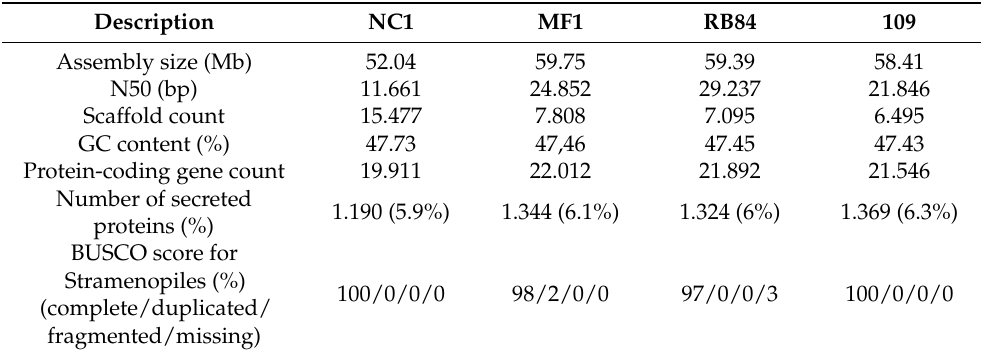
Table 3. Assembly statistics of four near-complete A. euteiches genome